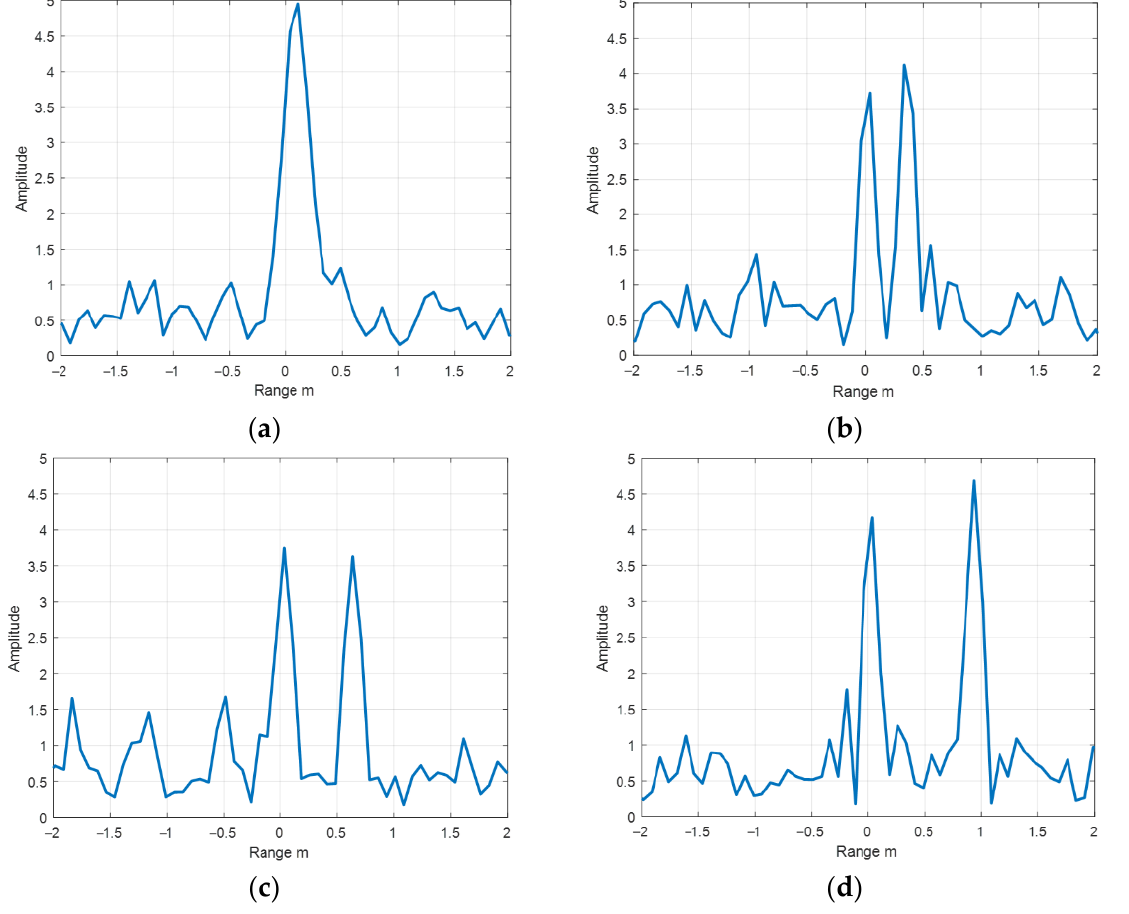
Figure 25. The echo diagram of two scattering points with a distance of ( a ) 0.15 m, ( b ) 0.3 m, ( c ) 0.6 m, and ( d ) 0.9 m under the condition of 12 dB SNR.